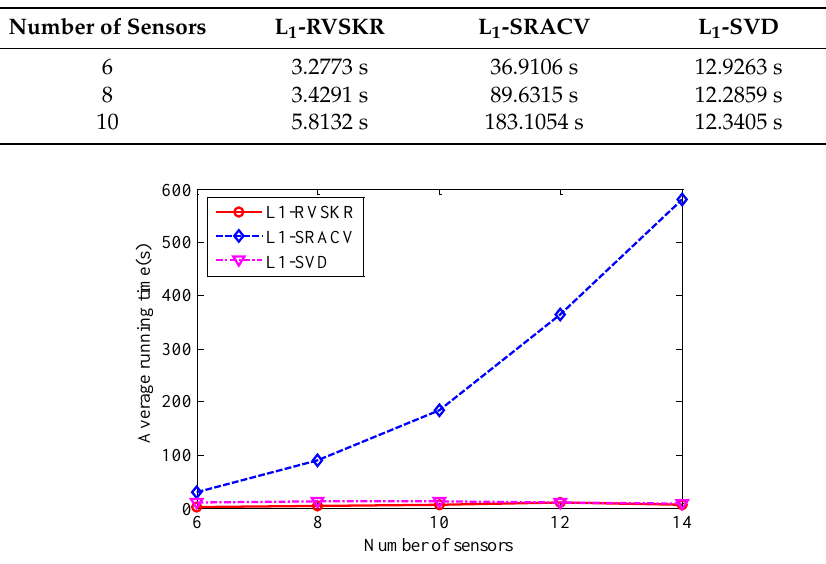
Figure 6. The average running time versus the number of sensors.